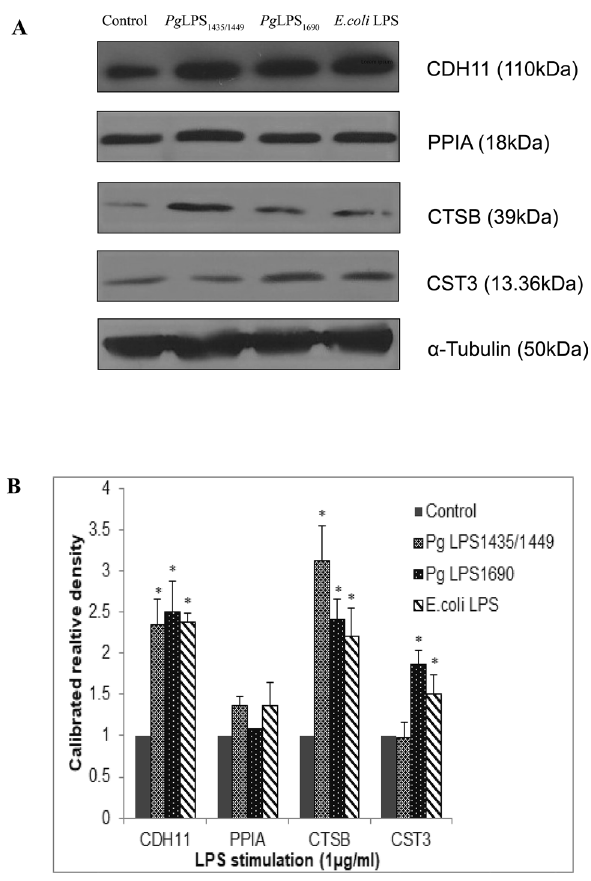
Figure 1. A correct version of the original Figure 4A. The expression of CDH11, PPIA, CTSB and CST3 proteins in P. gingivalis LPS- and E. coli LPS-stimulated HGFs analysed by Western blot. Confluent cells were treated with P. gingivalis LPS and E. coli LPS (1 μg/mL) for the indicated time points. 40 μg of homogenized, cellular extracts, were subjected to SDS-PAGE and probed with polyclonal antibodies against CDH11 (1:250), PPIA (1:1000), CTSB (1:1000) and CST3 (1:1000). Blots were reprobed with α-Tubulin to confirm the equal loading in individual samples. ( A )The fold increase values of proteins as compared with α-Tubulin are shown in the graphs (arbitrary units over control after normalization to the total protein). ( B ) One representative blot is shown from three independent experiments with similar results. * Significant difference with a P -value < 0.05 as compared with the controls without LPS